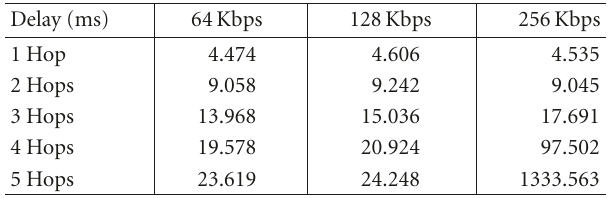
Table 2: Delay: multicast routing and autoconfiguration.